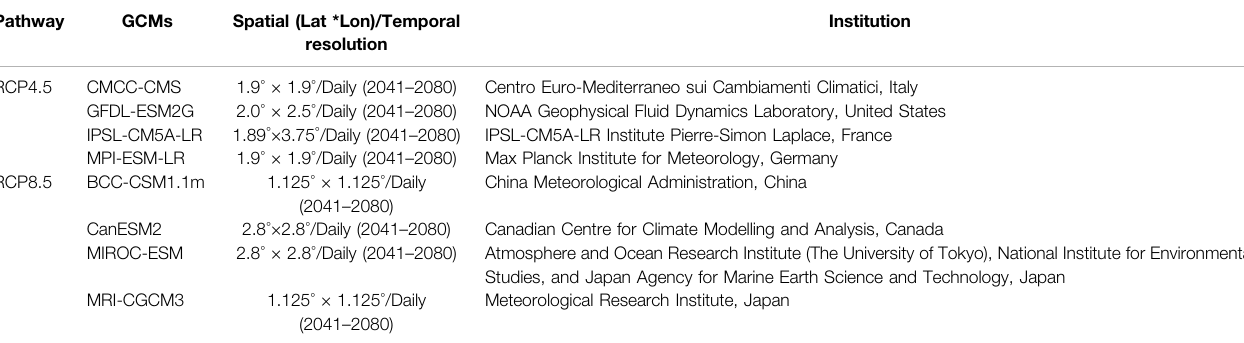
TABLE 1 | Basic information for the CMIP5 models selected for evaluation over the study area. Pathway GCMs Spatial (Lat *Lon)/Temporal